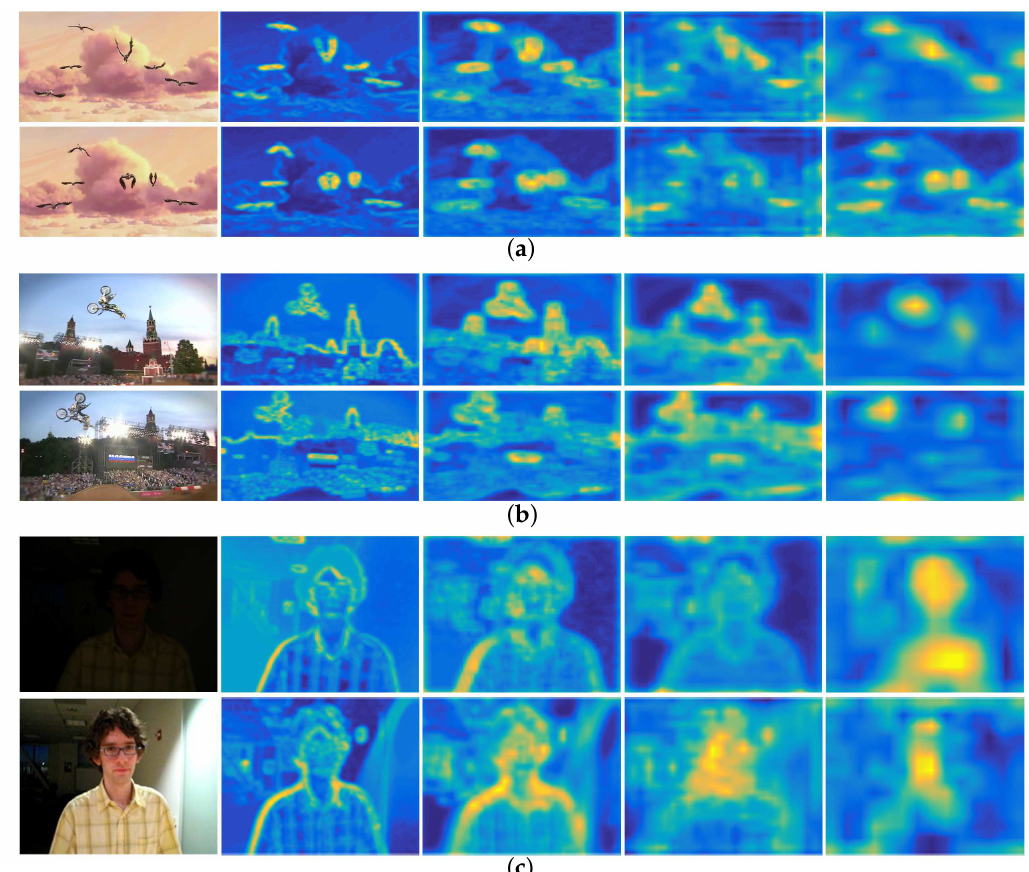
Figure 2. Visualization of input and outputs of different layers. From left to right are the input frame, feature maps of conv2-2, feature maps of conv3-4, feature maps of conv4-4, and feature maps of